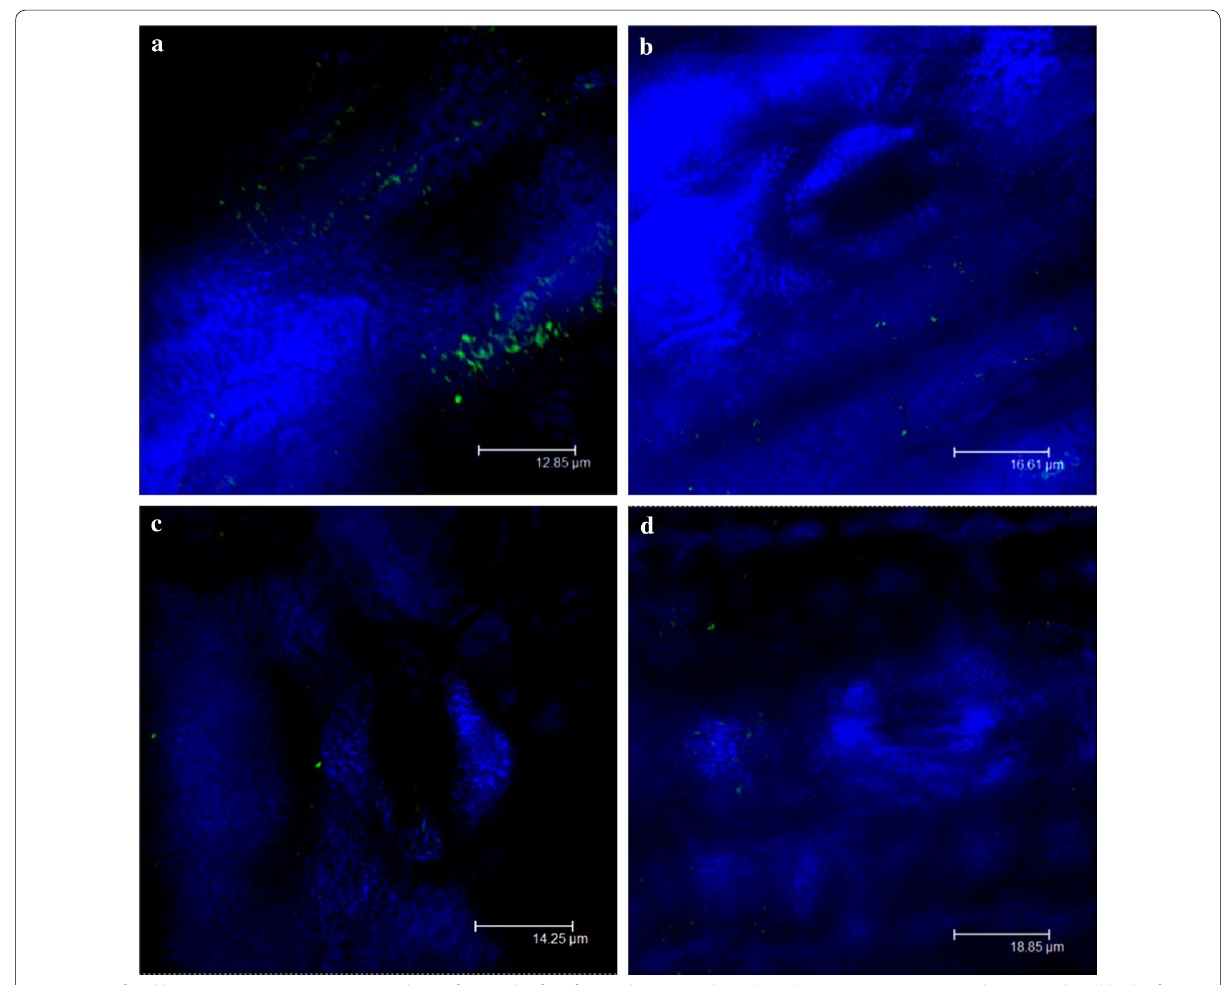
Fig. 4 Confocal laser scanning microscopy analysis of maize leaf surface colonization by A. brasilense expressing EGFP when inoculated by leaf spray. a A. brasilense Ab-V5 after 1 h, b A. brasilense Ab-V5 after 1 day, c A. brasilense Ab-V6 after 1 h, d A. brasilense Ab-V6 after 1 day of